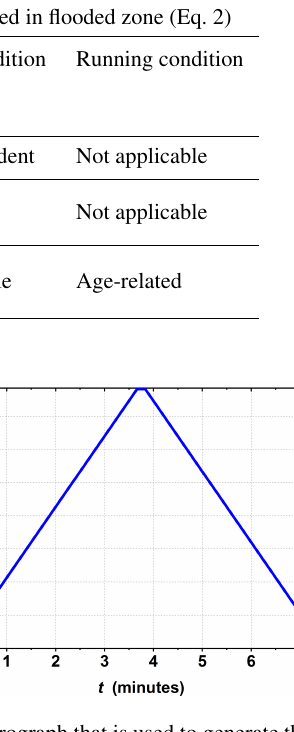
Figure 3. Inflow hydrograph that is used to generate the floodwater propagation from the southern side of the shopping